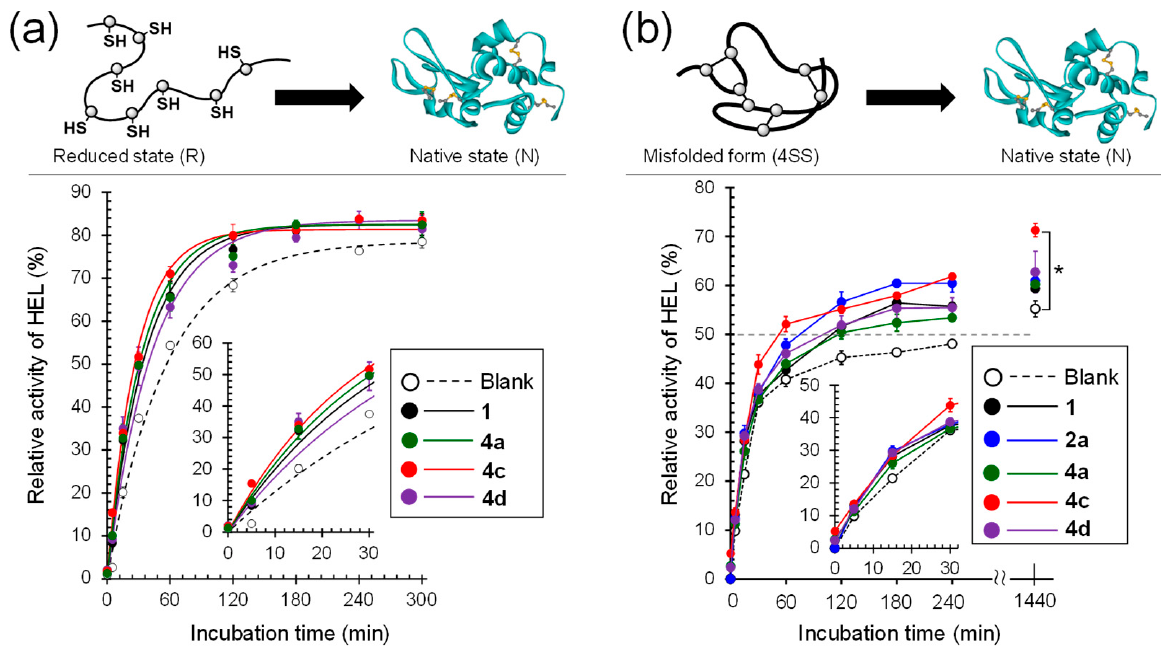
Figure 6. Comparison of the rates of oxidative folding of R HEL and refolding of 4SS. Selected data are shown, and all other data for 1 -Gly-Xaa (series 4 ) are shown in supporting information (Figure S1). Data are shown as means ± SEM ( n = 3). ( a ) Enzymatic activity recovered during the oxidative folding of R HEL . The reaction conditions were [R HEL ] 0 = 10 µ M, [GSH] 0 = 1.0 mM, [GSSG] 0 = 0.20 mM, [catalyst] = 0 or 20 µ M, 37 ◦ C, and pH 7.5 in the presence of 1 M urea. Circles and lines represent experimental data and simulations, respectively, which are drawn using the apparent rate constants ( k ). ( b ) Enzymatic activity recovered during the refolding of 4SS. The reaction conditions were [4SS] 0 = 10 µ M, [GSH] 0 = 1.0 mM, [catalyst] = 0 or 20 µ M, 37 ◦ C, and pH 7.5 in the presence of 1 M urea. Table 1. Summary of obtained parameters a .